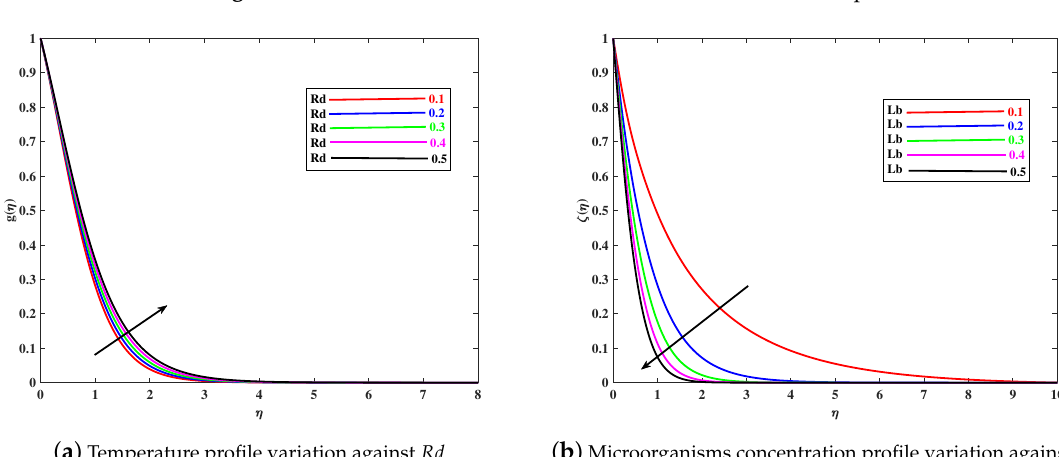
Figure 8. Effect of Nt to influence the thermal and concentration profile.